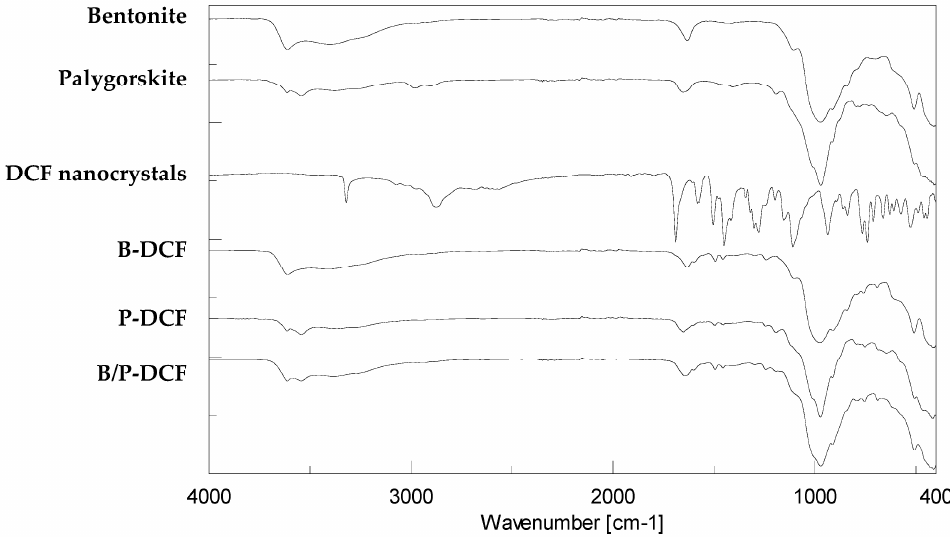
Figure 5. FTIR of the pristine components and gels (B-DCF, P-DCF, and B/P-DCF). In Figure 6, TGA (top panel) and DSC (bottom panel) spectra of diclofenac nanocrystals-loaded inorganic hydrogels (B-DCF, P-DCF, and B/P-DCF) have been reported.